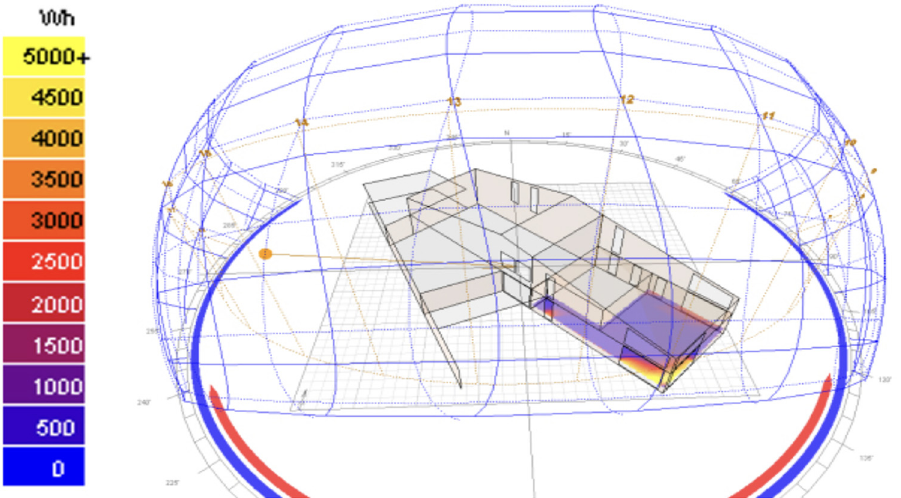
Fig. 6. Ecotec Architectural Of fi ce “ Betão e Taipa ” Simulation with incoming solar radiation.